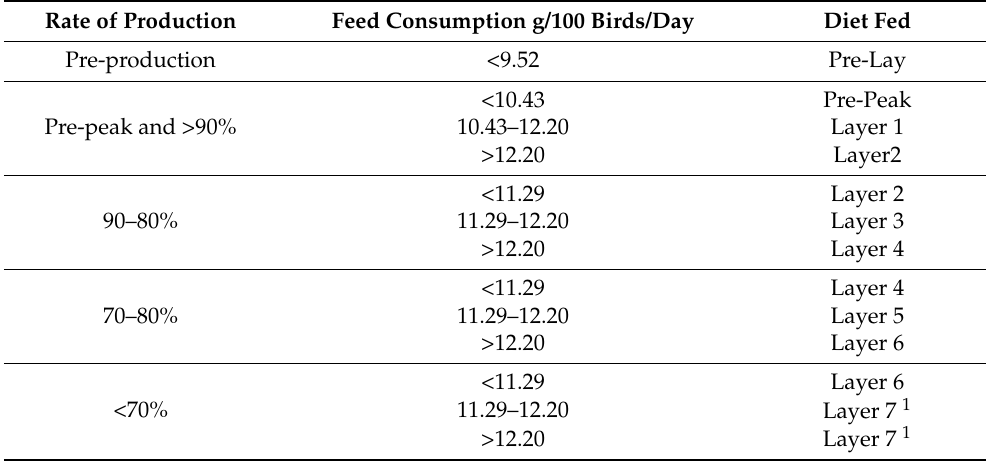
Table 2. Feeding program of diets according to egg production rate and ad libitum consumption